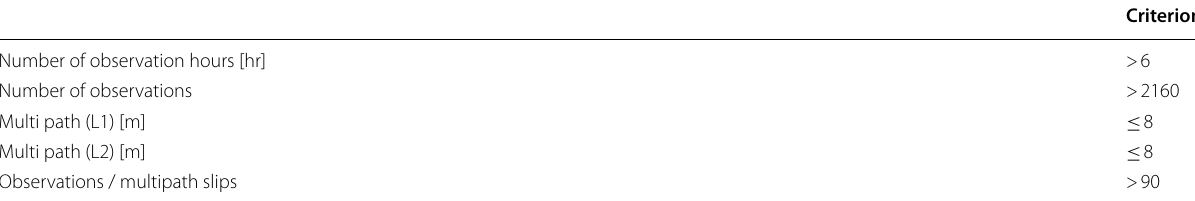
Table 3 Quality check criteria for the preprocessing